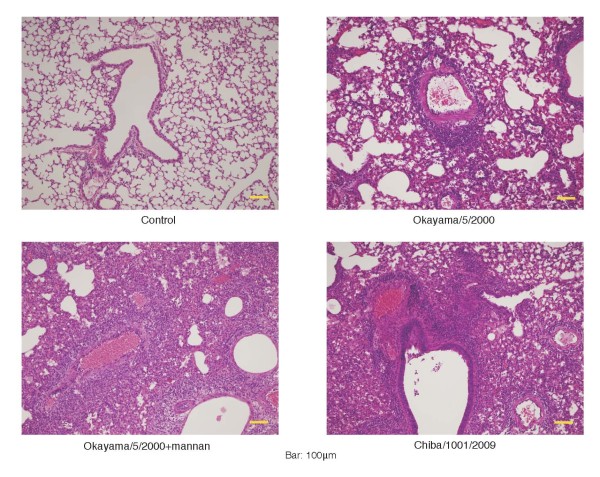
Histopathological observation of the lungs of virus-inoculated mice. On day 8 after infection, the lungs were removed from the mice under anesthesia and subjected to histopathological examination. Lung section of the mouse co-inoculated with mannan is also shown.